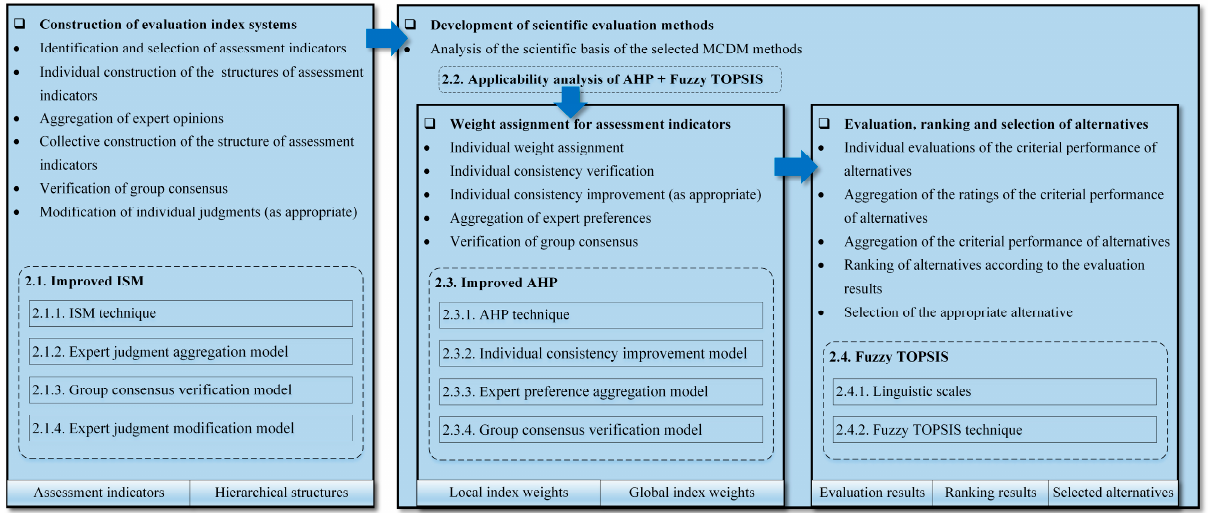
Figure 1. The framework of research methodology.